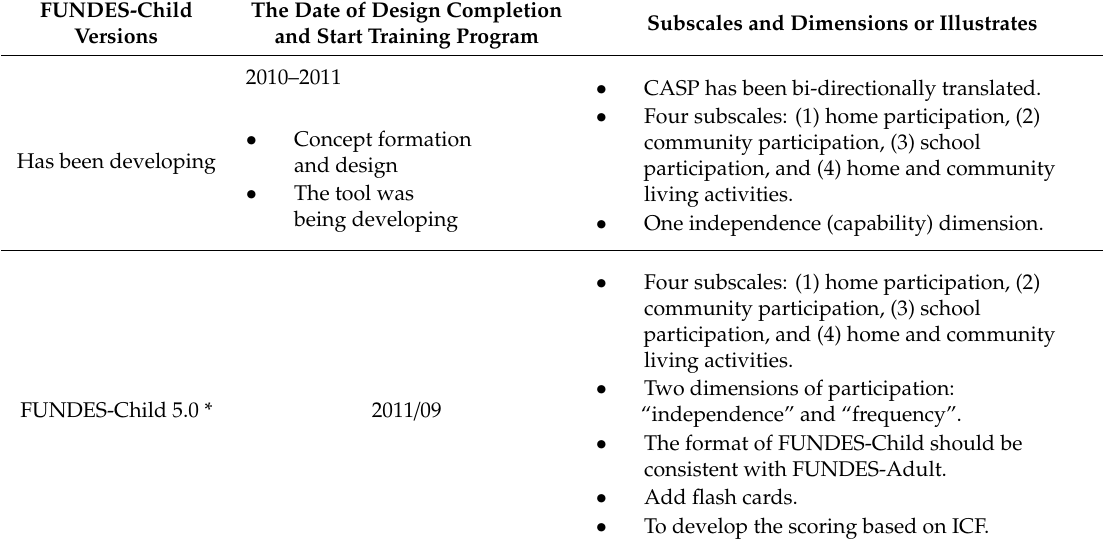
Table 1. The process of the Functioning Scale of the Disability Evaluation System-Child version (FUNDES-Child) tools